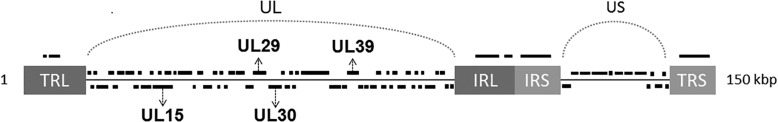
Map of the HSV-2 genome. The HSV genome is a linear double-stranded DNA of around 150 kbp that encodes at least 74 genes (black rectangles). It is composed of two covalently linked segments named as unique long (UL) and unique short (US) sequences (heavy solid lines). Each segment is bracketed by the terminal and internal inverted repeats sequences TRL-IRL and IRS-TRS (gray boxes). kbp: kilo base pairs.